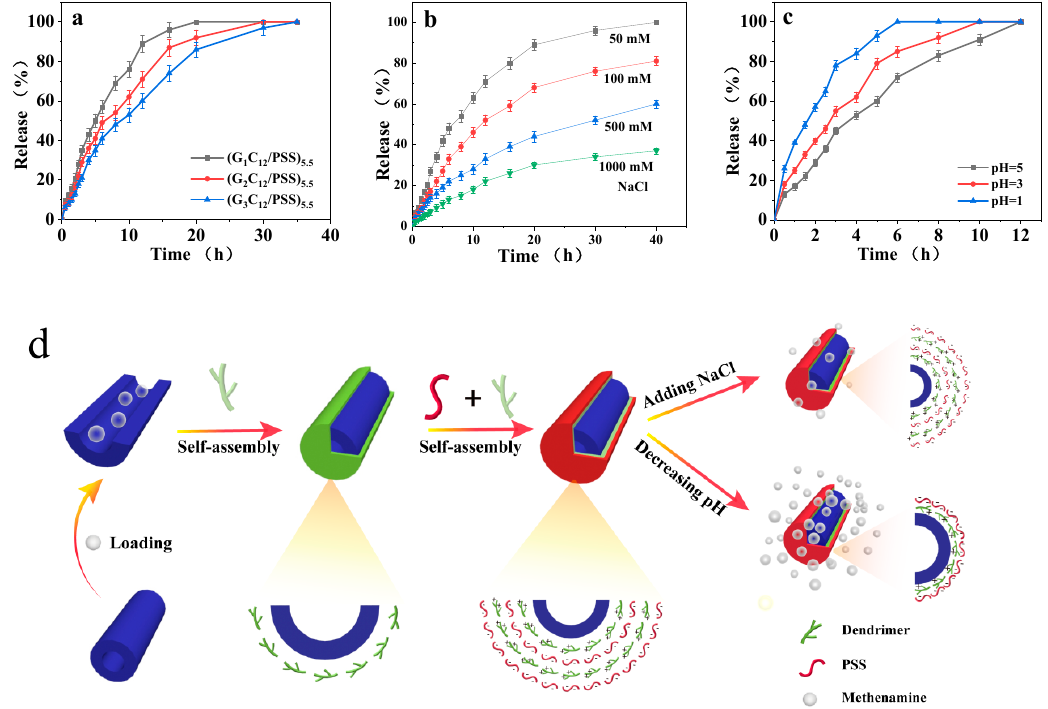
Figure 4. Release profiles of methenamine from different systems: ( a ) LbL assemblies in the presence of different dendrimer generations, ( b ) in the presence of NaCl at different concentrations in HNTs@(G 3 C 12 /PSS) 5.5 systems, ( c ) under different pH values, and in the presence